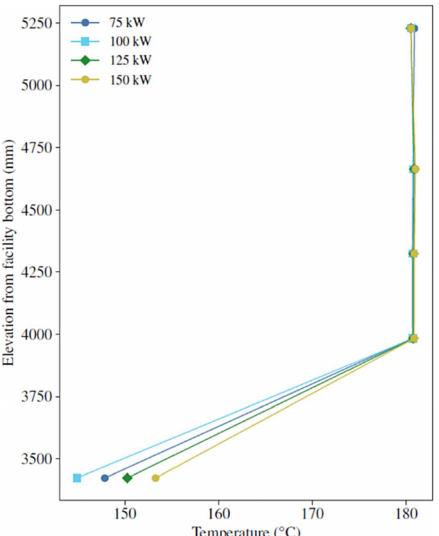
Fig. 6. Averaged axial temperature profiles of all steam gener- ator tubes with different core power levels during the MS-SG02